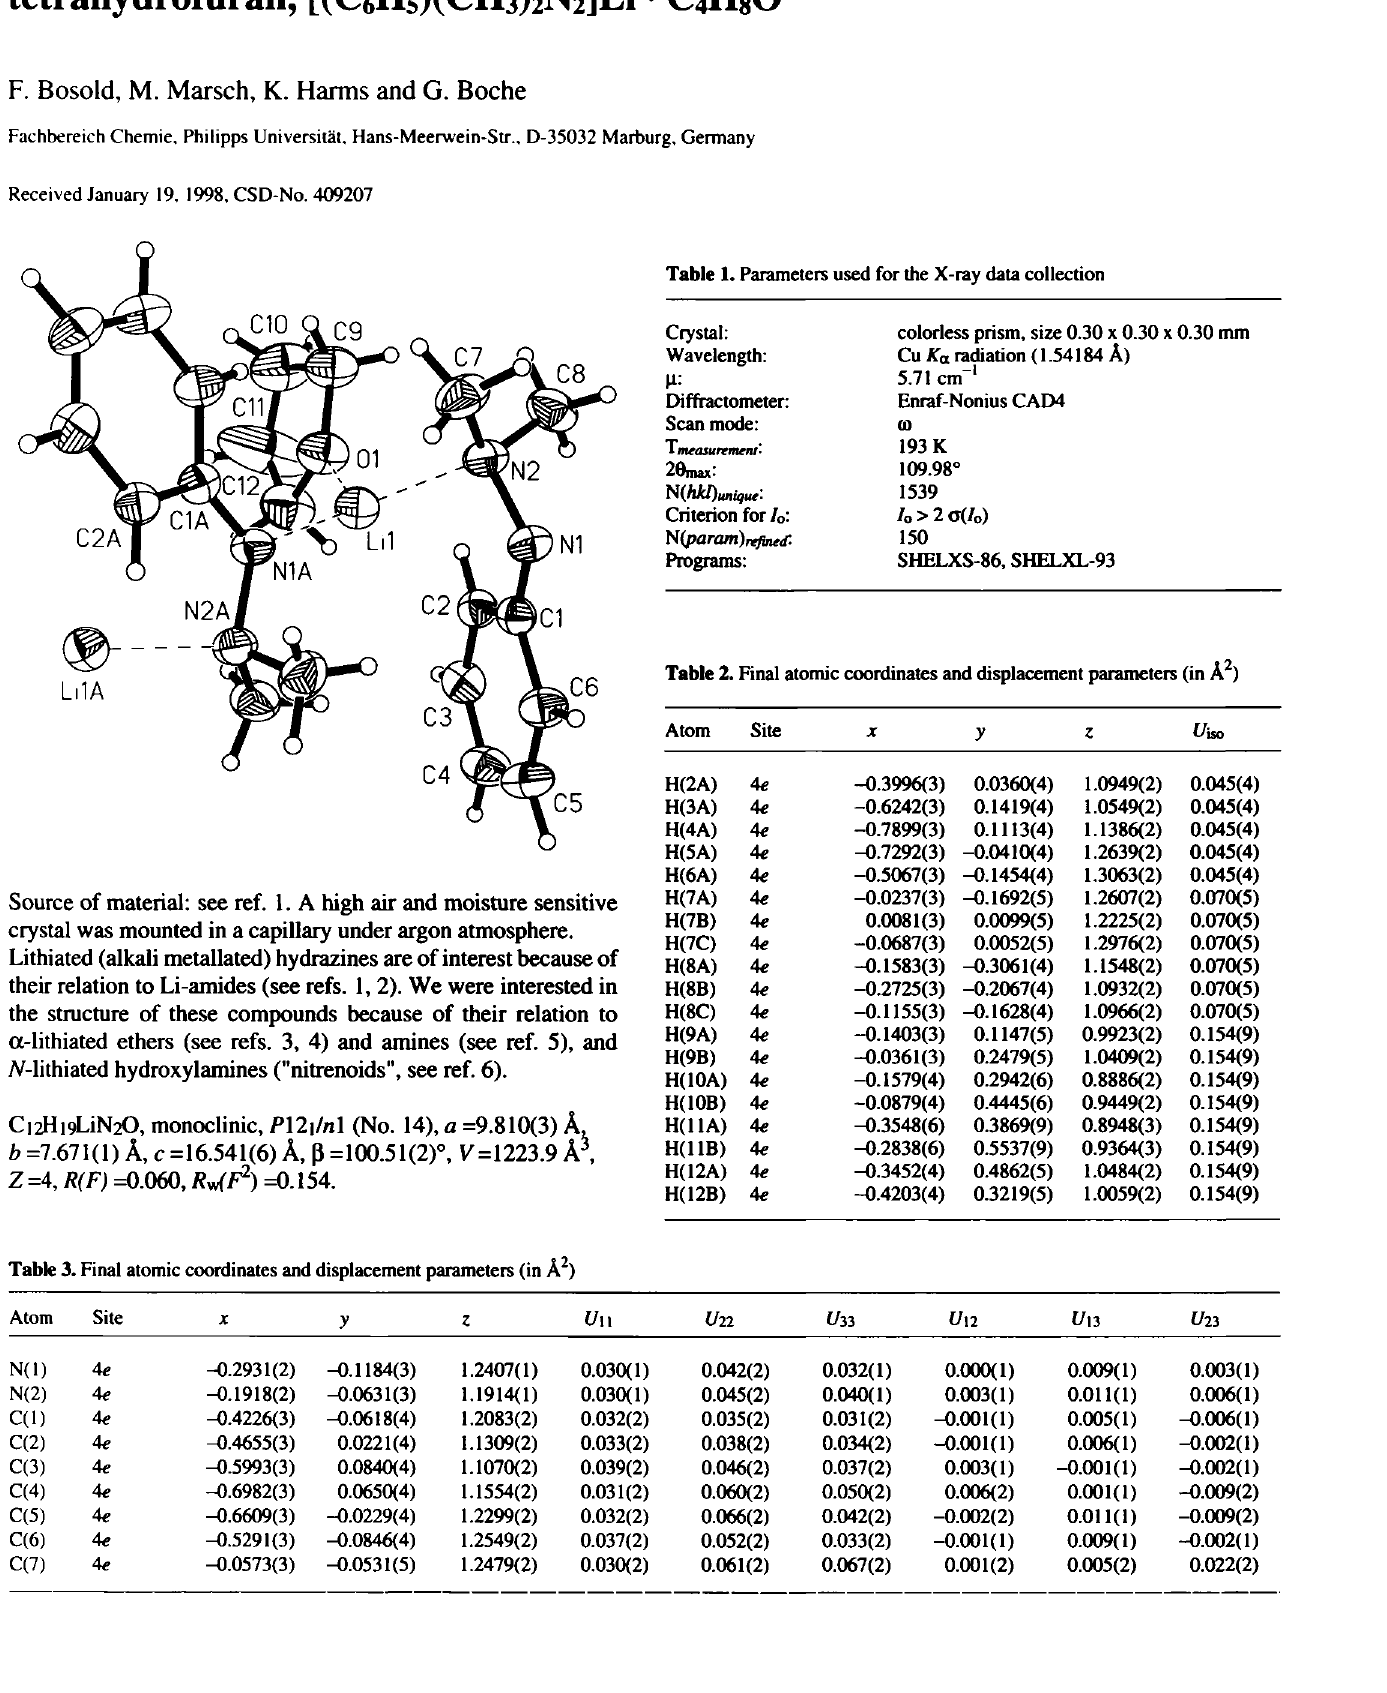
Table 1. Parameters used for the X-ray data collection Crystal: